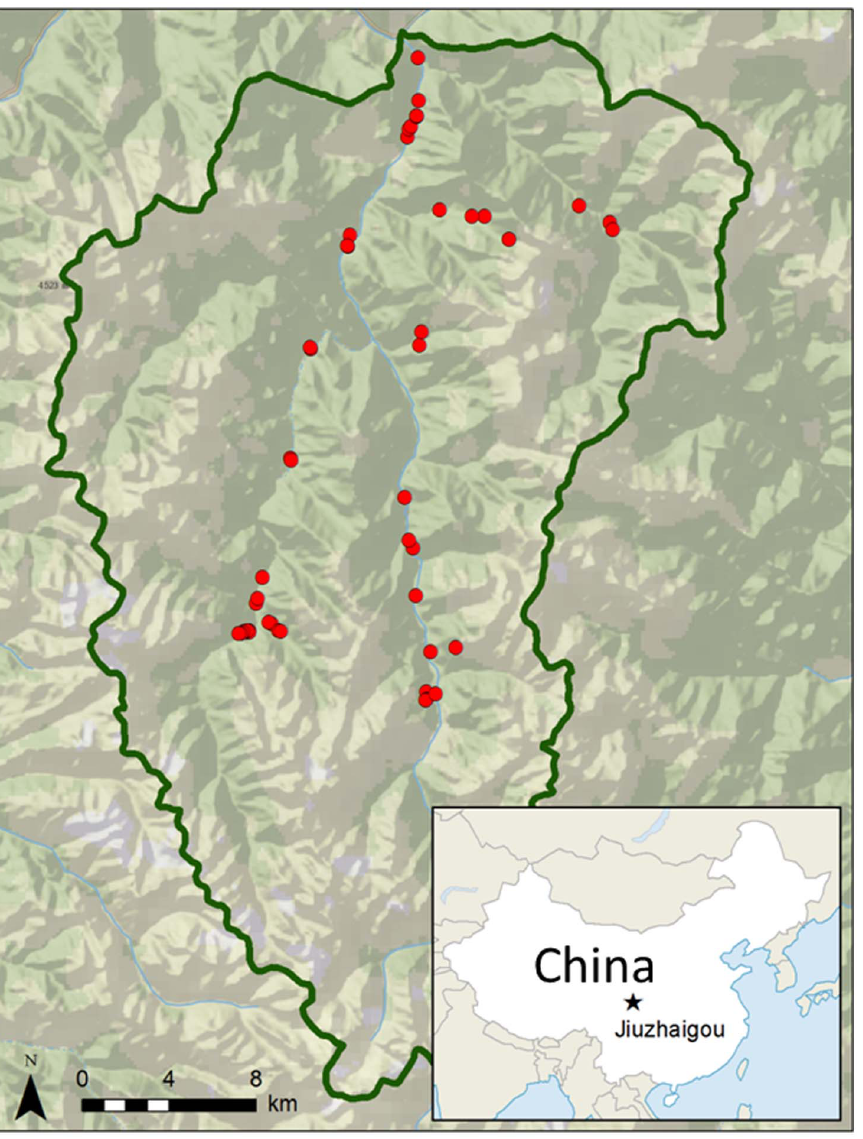
Figure 1. A map of Jiuzhaigou National Nature Reserve. The map shows plot sampling locations (red dots), and location of Reserve in the context of China (inset).